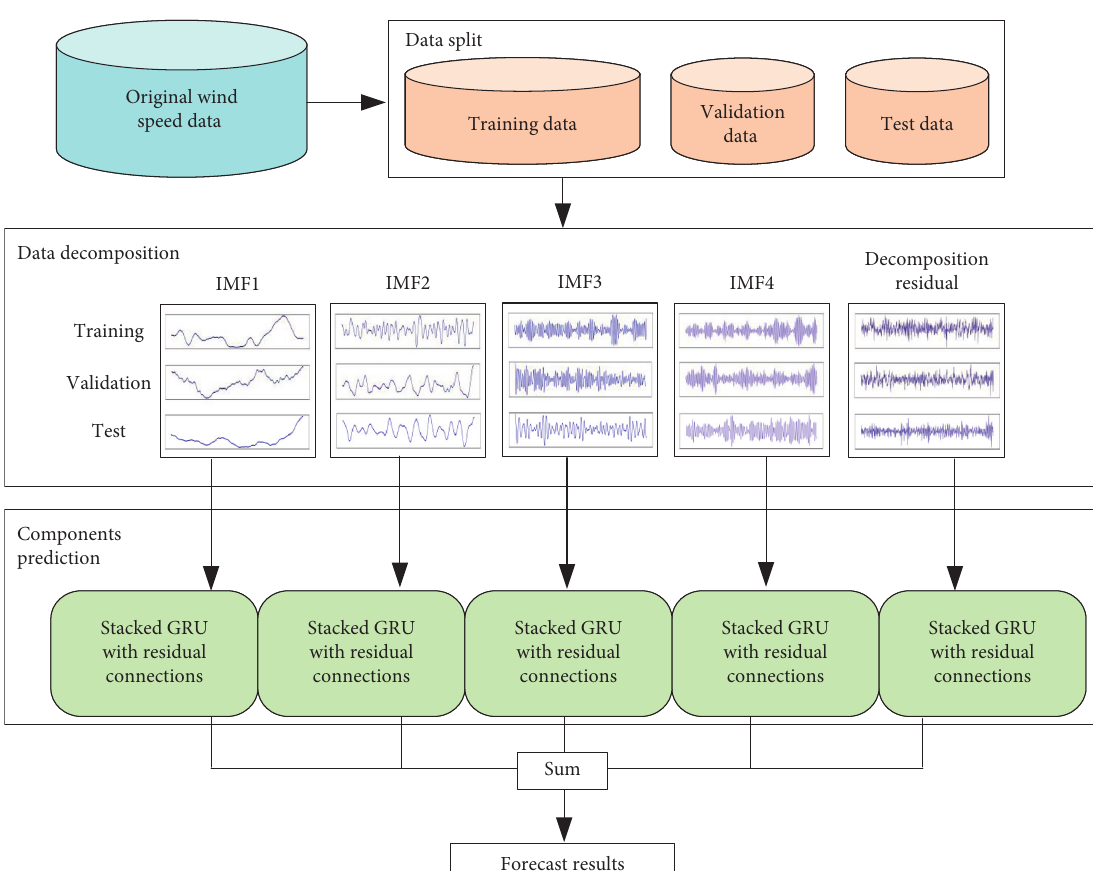
Figure 5: Architecture of the proposed